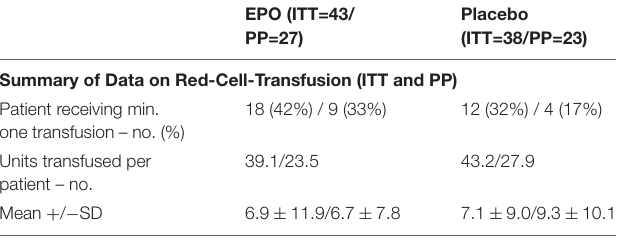
TABLE 5 | Packed red cell units transfused.